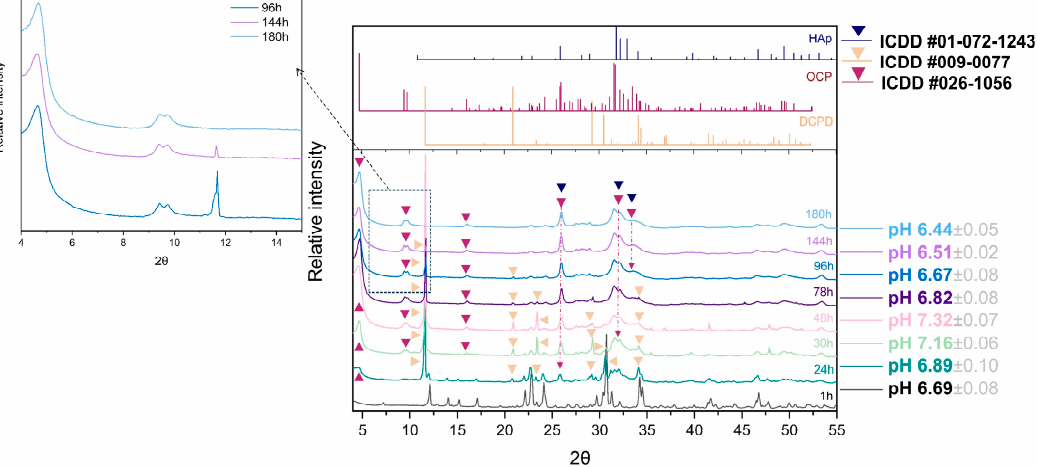
Figure 2. Hundredfold scale-up (100 × SC): sequence of XRD patterns illustrating the gradual transition from α -TCP phase via DCPD to OCP phase at pivotal time points chosen due to the prevalent, visually noticed change, accompanied by the fluctuation in pH